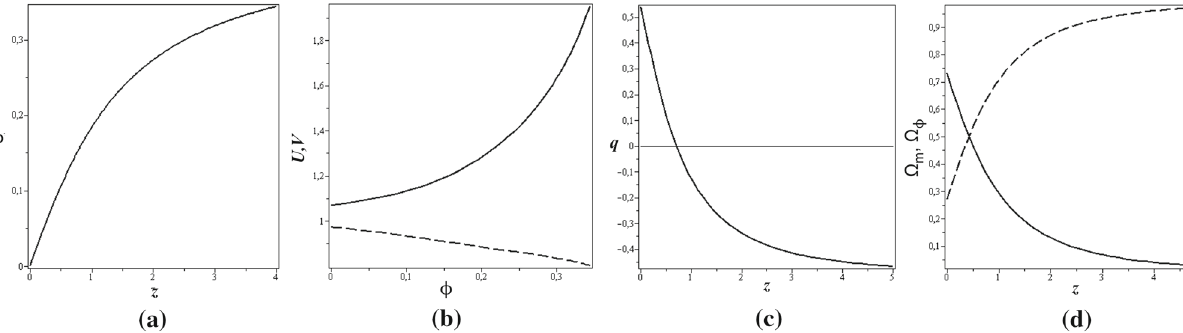
Fig. 4 a Plot of φ as a function of z . b Plot of V (solid curve) and U (dashed curve) as a function of φ . c Plot of q as a function of z . d Plot of Ω φ (solid curve) and Ω m (dashed curve) as a function of z . This is for BA parametrization, with Ω = 0 . m 0